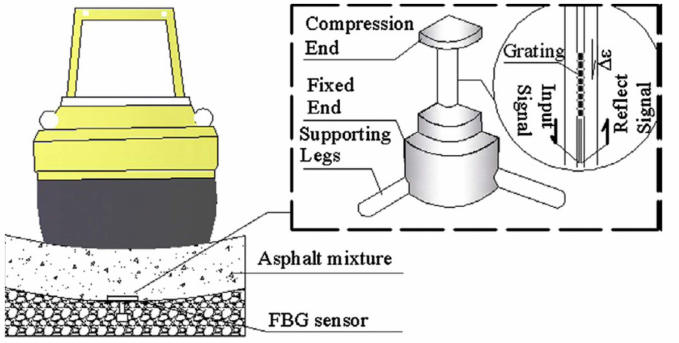
Figure 9. FBG sensor embedded in asphalt pavement